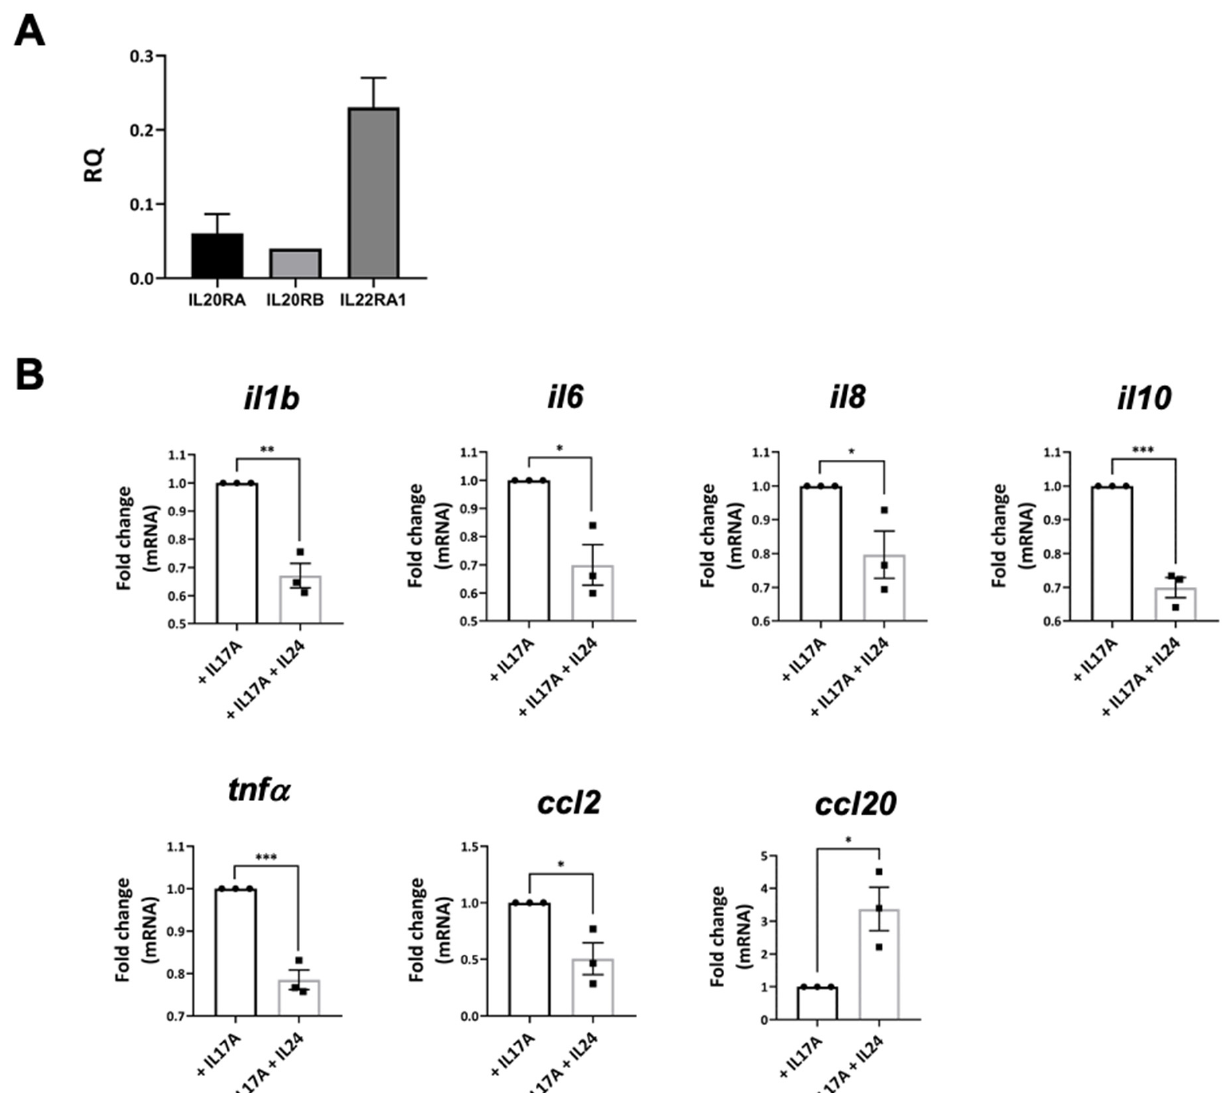
Figure 5. IL-24 inhibited the production of inflammatory cytokines in ARPE-19 cells. ( A ) Gene expression of IL-24 receptor in ARPE-19 cells was determined by qPCR. ( B ) ARPE-19 cells were stimulated by recombinant IL-17A with and without recombinant IL-24. After 24 h of incubation, the relative gene expressions of il1b , il6 , il8 , il10 , tnfa , ccl2, and ccl20 were measured by qPCR. Data represent means ± SEMs of three independent experiments. * p < 0.05, ** p < 0.01, *** p < 0.001, Student’s t test.